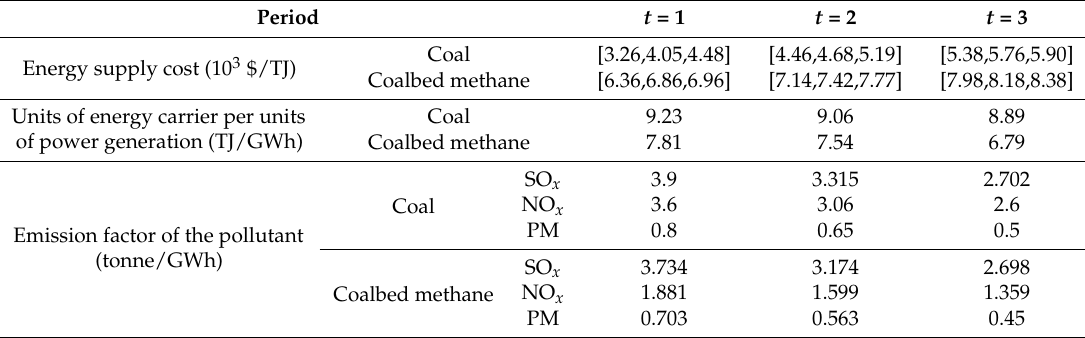
Table 2. Cost of primary energy supply and conversion parameters.